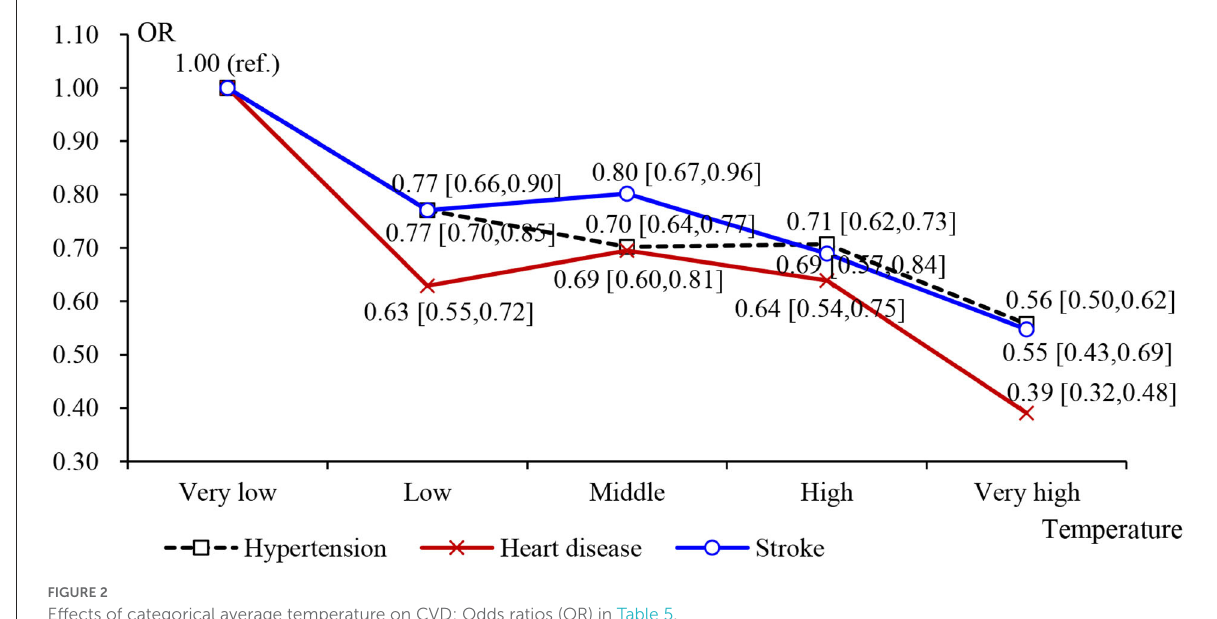
FIGURE2 Effects of categorical average temperature on CVD: Odds ratios (OR) in Table 5.